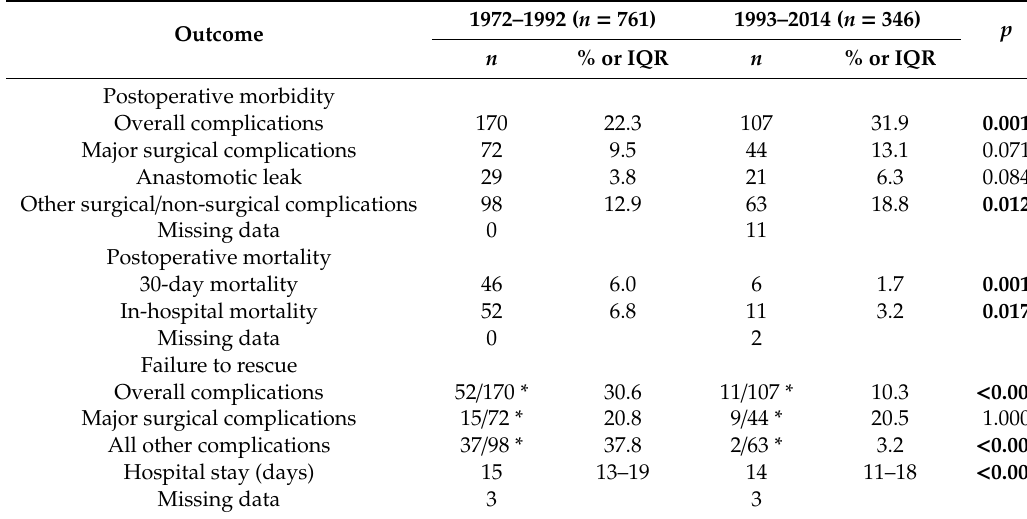
Table 3. Postoperative outcomes.